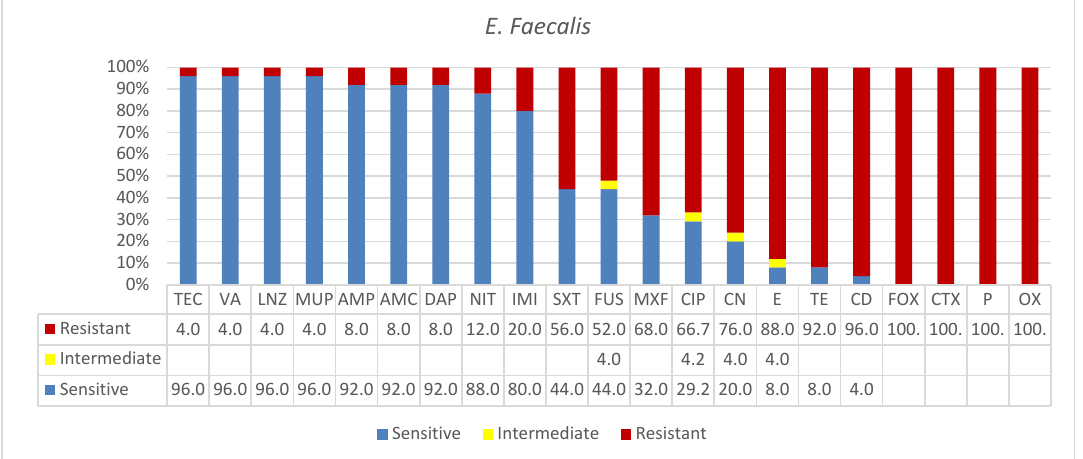
Figure 3. Antimicrobial sensitivity patterns of E. faecalis isolates to 21 antibiotics. Abbreviations (in the order in which they appear in the figure): TEC teicoplanin, VA vancomycin, LNZ linezolid, MUP mupirocin, AMP ampicillin, AMC ampicillin/sulbactam, DAP daptomycin, NIT nitrofuran, IMI imipenem, SXT trimethoprim/sulfamethoxazole, FUS fusidic acid, MXF moxifloxacin, CIP ciprofloxacin, CN gentamicin, E erythromycin, TE tetracycline, CD clindamycin, FOX cefoxitin, CTX cefotaxime, P penicillin, OX oxacillin.